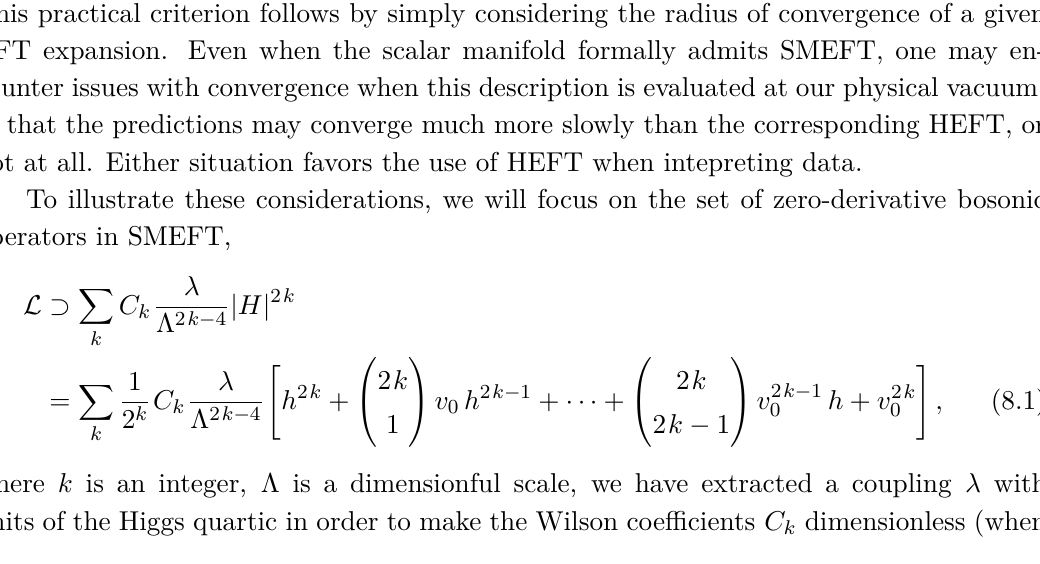
Figure 4 . EFT submanifolds in the triplet model obtained by matching in the unitary basis for two representative sets of parameters, one with m 2 > 0 (left panel) and the other with m 2 < 0 (right panel). In each panel, contours of the potential eq. (7.48) are shown in the ( r, f ) plane in arbitrary mass units with the indicated choice of parameters. We fix β i = 0 . The location of the global minimum is denoted by a black dot, while the fixed point corresponds to ( r, f ) = (0 , 0) . The EFT submanifolds are shown in blue and orange; blue corresponds to solution(s) of ∂V in regions where the UV fluctuations (in f and β i ) have a positive definite mass matrix, and the curve is orange otherwise. The region in which the UV fluctuations do not have a positive definite mass matrix is shown in light gray, with a dashed green boundary. In the left panel, the choice of parameters (namely m 2 > 0 ) admits a SMEFT, as illustrated by the existence of an EFT submanifold connecting the UV fixed point to the global minimum through a region of positive definite mass matrix. In the right panel, the choice of parameters (namely m 2 < 0 ) requires a HEFT, as none of the EFT submanifolds connect the fixed point to the global